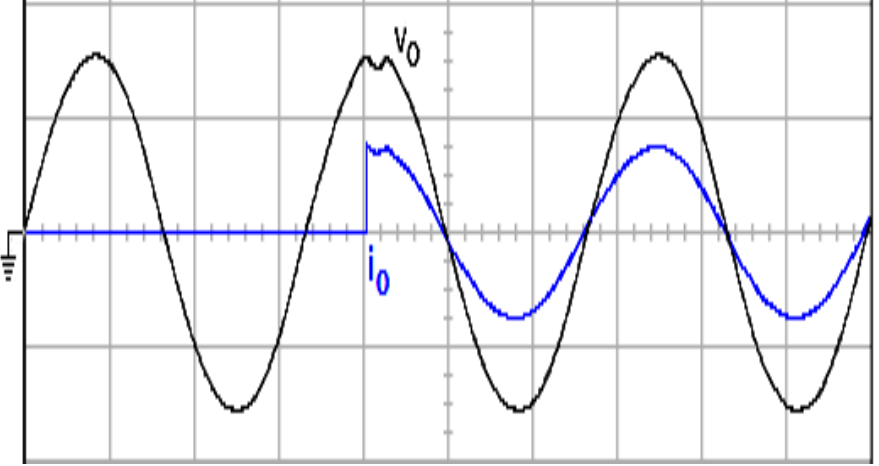
Figure 9. Experimental waveform under a step change in load for the modified control technology (100 V/div; 20 A/div; 5 ms/div).